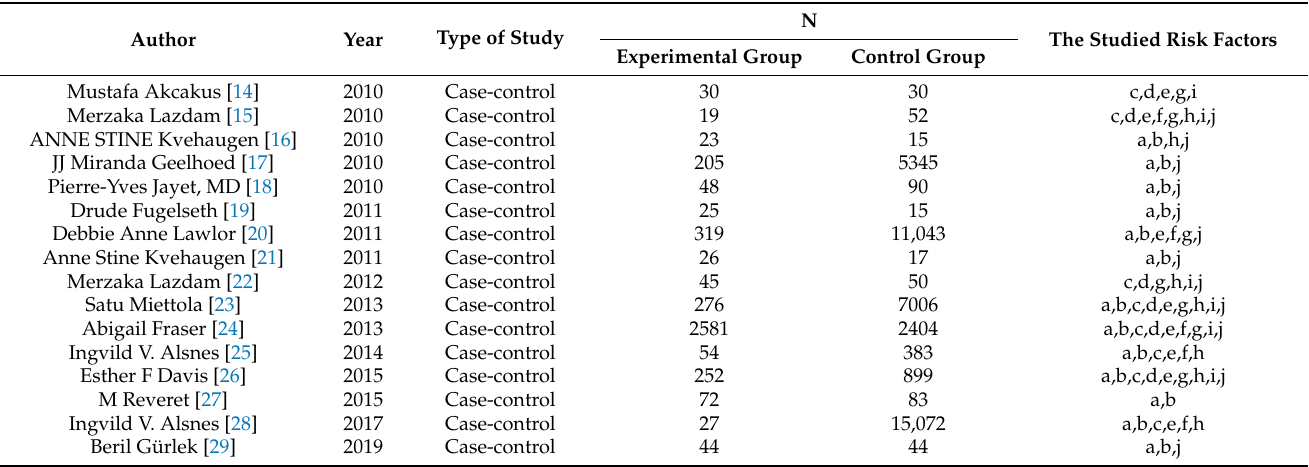
Table 2. Basic information of included